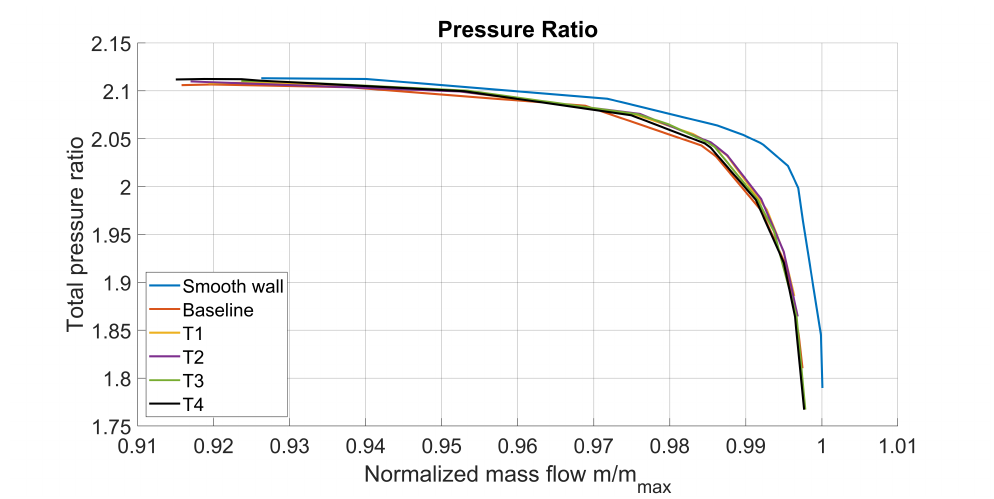
Figure 16. Total Pressure Ratio T-shape configurations compared to the smooth wall case.